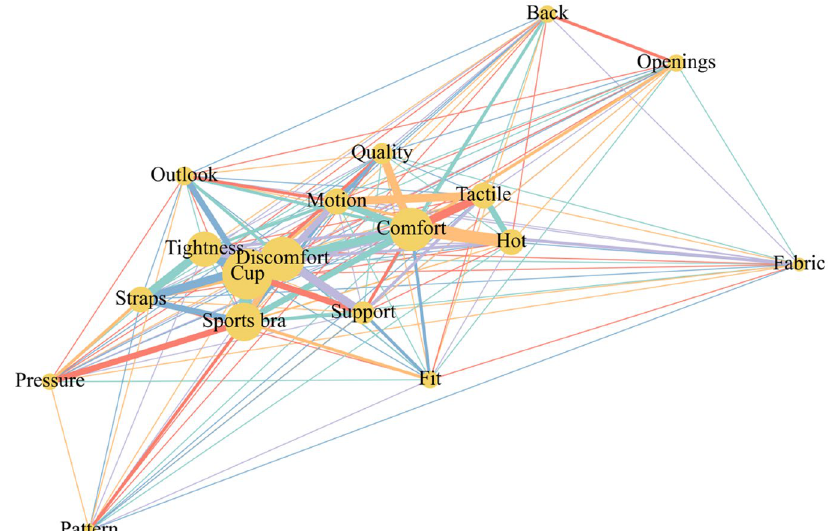
Fig. 1 Networks of design attributes and perceptions of the elderly women for a sports bra. The links among keywords were illustrated, in the order of largest to lowest, green, yellow, orange, blue, and purple. The distance among nodes (keywords) represents their closeness